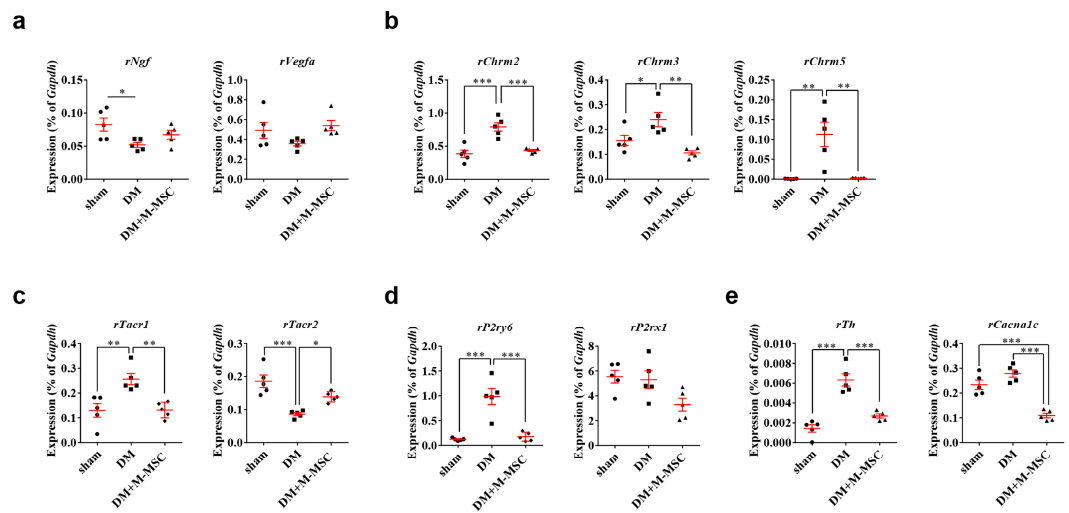
Figure 8. M-MSC therapy restored expression of genes related to diabetic DUA ( a – e ) RQ-PCR measurement of mRNA levels for genes related to the pathogenesis of diabetic DUA in the bladders of DM rats at 1 week after injection of M-MSCs or PBS. These genes included ( a ) growth factors such as Nerve growth factor ( Ngf ) and Vascular endothelial growth factor-A ( Vegfa ), ( b ) cholinergic muscarinic receptors, ( c ) tachykinin receptors, ( d ) Pyrimidinergic receptor ( P2ry6 ) and Purinergic receptor P2X-1 ( P2rx1 ), and ( e ) tyrosine hydroxylase ( Th ) and calcium voltage-gated channel subunit alpha1-C ( Cacna1c ). Expression levels of the indicated transcripts are presented as % Gapdh . Expression levels ( n = 5 animals / group) are presented as means ± SEM. (* p < 0.05, ** p < 0.01, and *** p < 0.001 relative to DM group, one-way ANOVA).